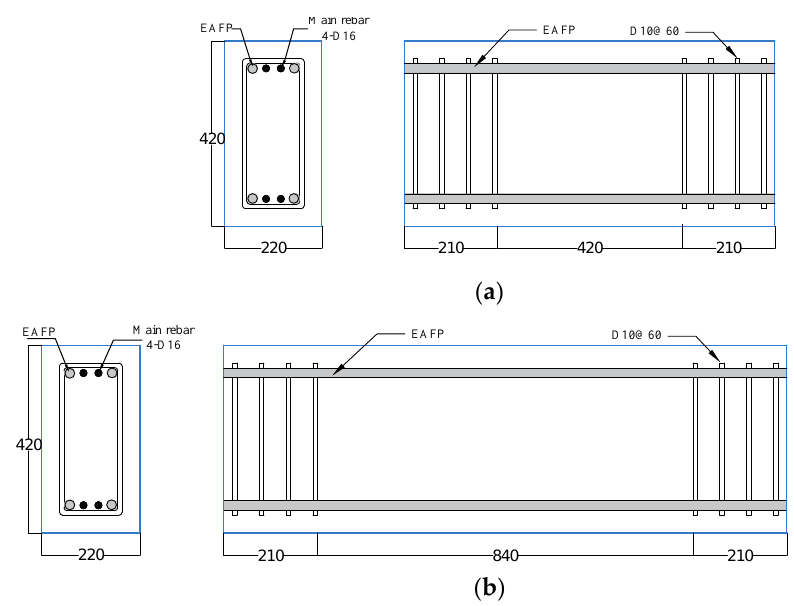
Figure 3. Rebar arrangement of monitor specimen: ( a ) short specimen; ( b ) long specimen.